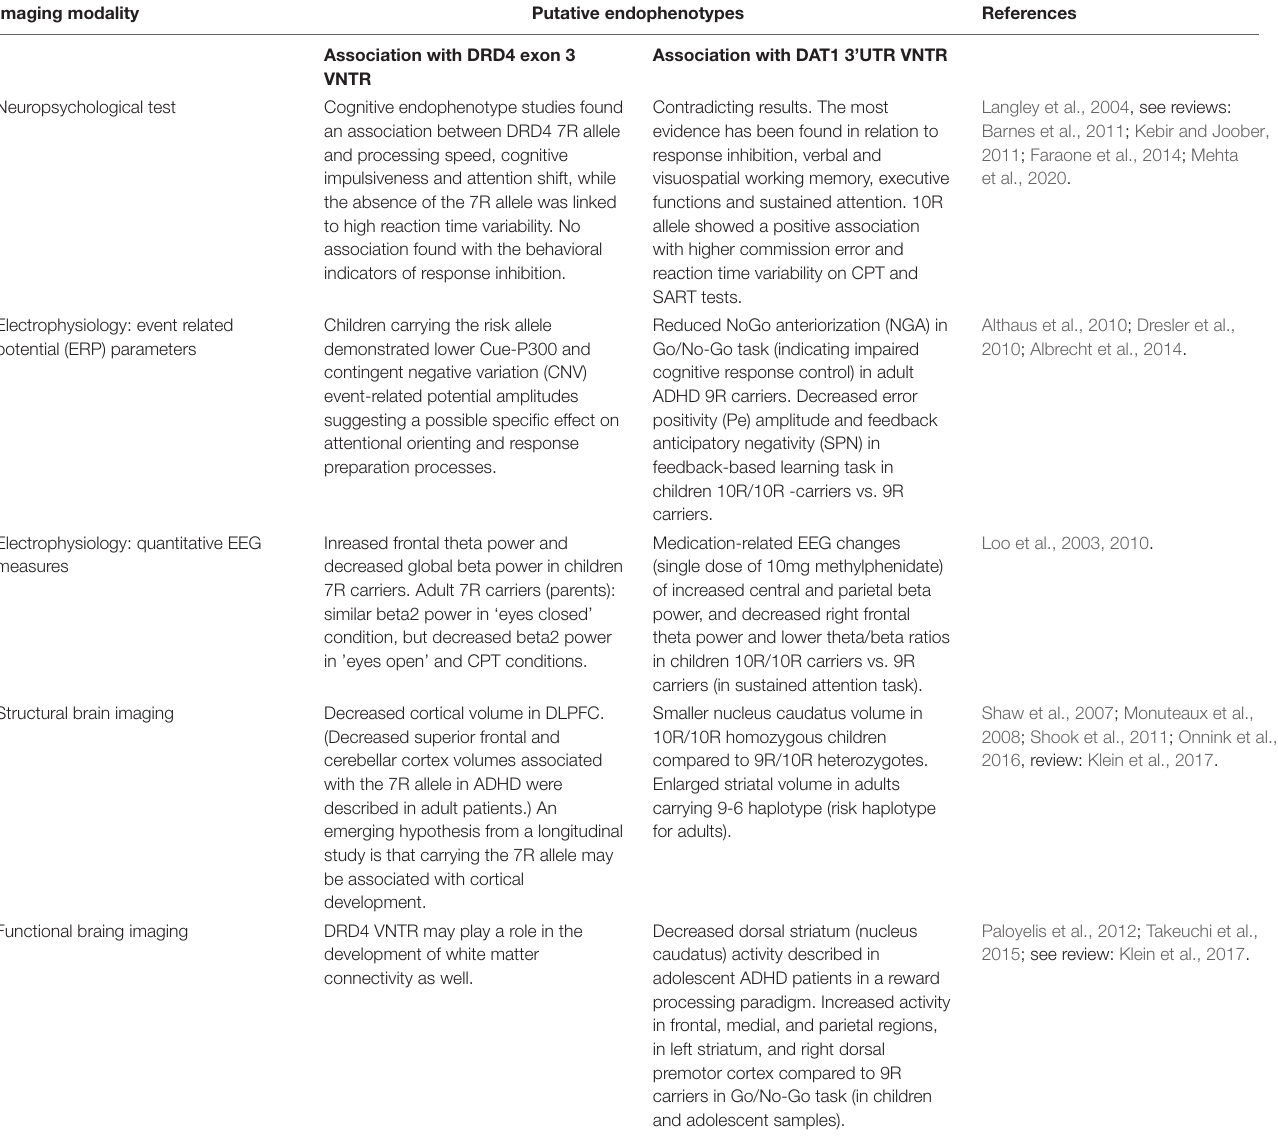
TABLE 1 | Association of VNTR polymorphisms in candidate genes DRD4 and DAT1 with various ADHD-related neuropsychological, eletrophysiological and neuroimaging measures emerging as putative endophenotypes. Imaging